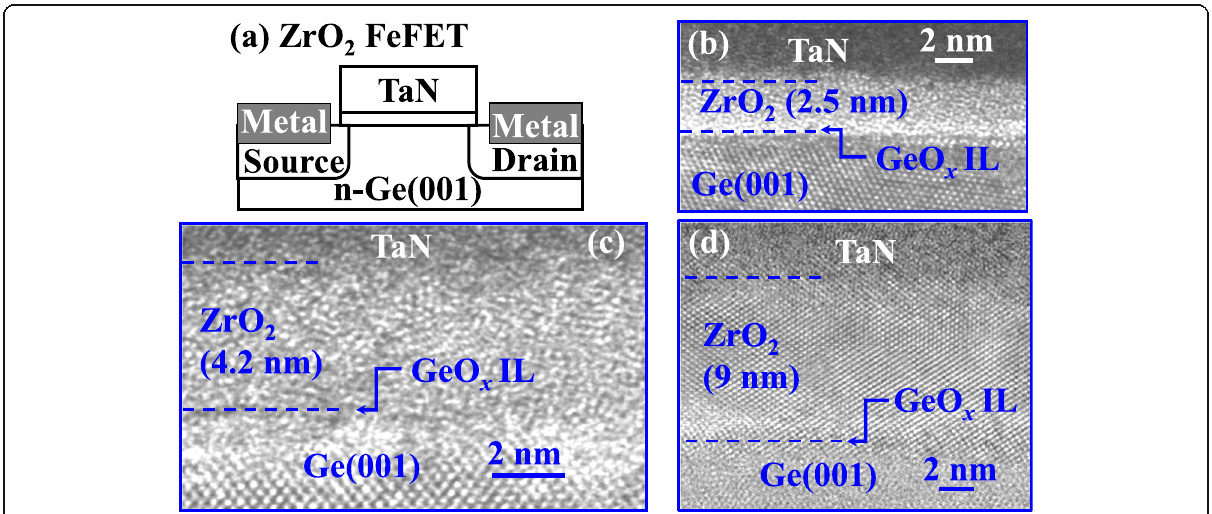
Fig. 1 a Schematic of the fabricated TaN/ZrO 2 /Ge FeFET. b , c , and d HRTEM images of the TaN/ZrO 2 /Ge stacks with different ZrO 2 thicknesses. The samples underwent an RTA at 500 °C for 30